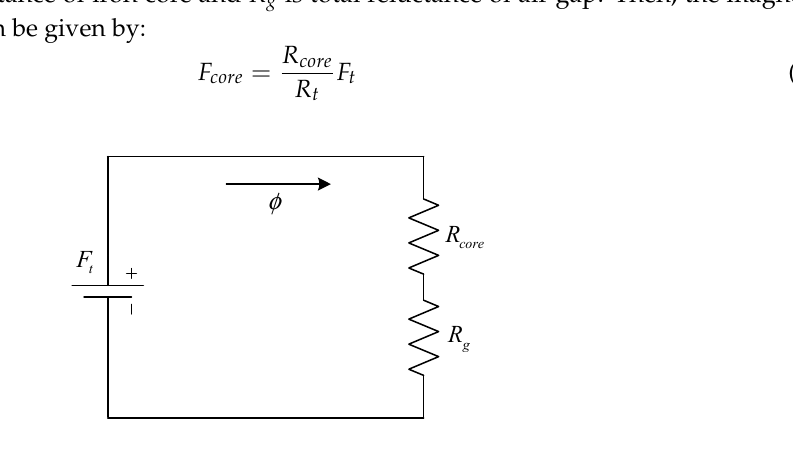
Figure 5. Magnetic circuit with single excited phase.